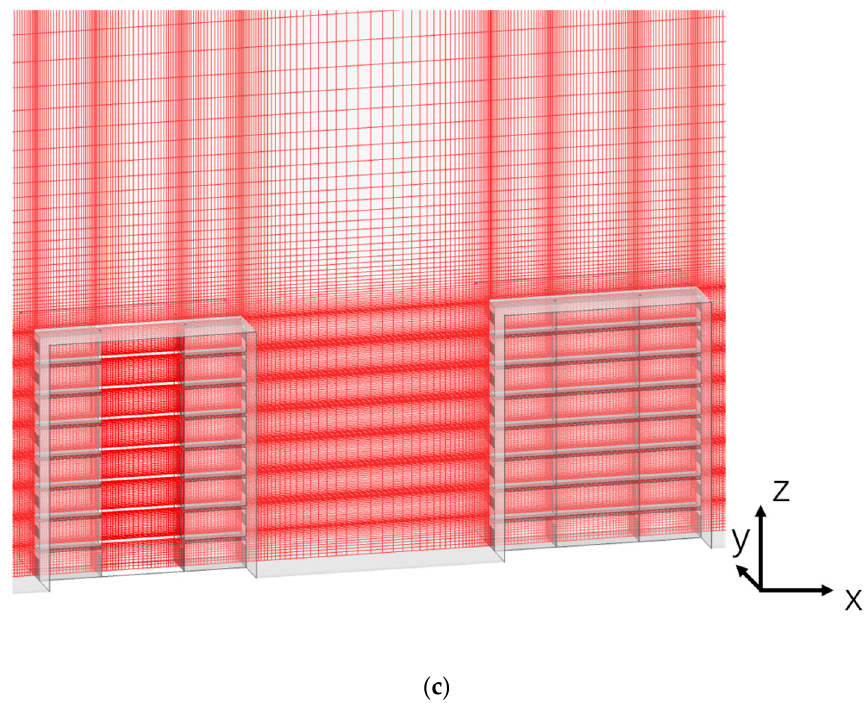
Figure 2. Street canyon models ( a ) and mesh arrangements. ( b ) is the mesh for single-side ventilation scenarios and ( c ) is the mesh for cross ventilation scenarios.